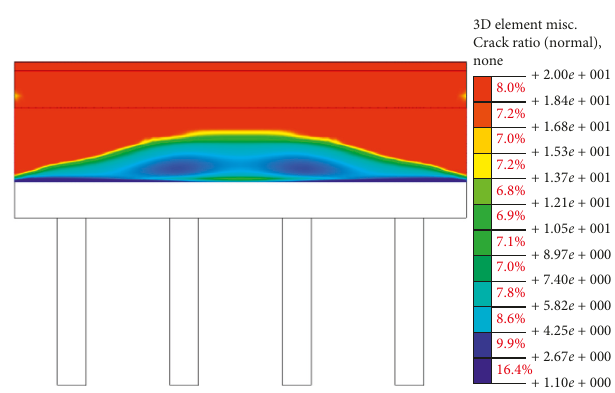
Figure 9: Temperature crack coefficient of the abutment. Table 3: Nominal shrinkage coefficient ε